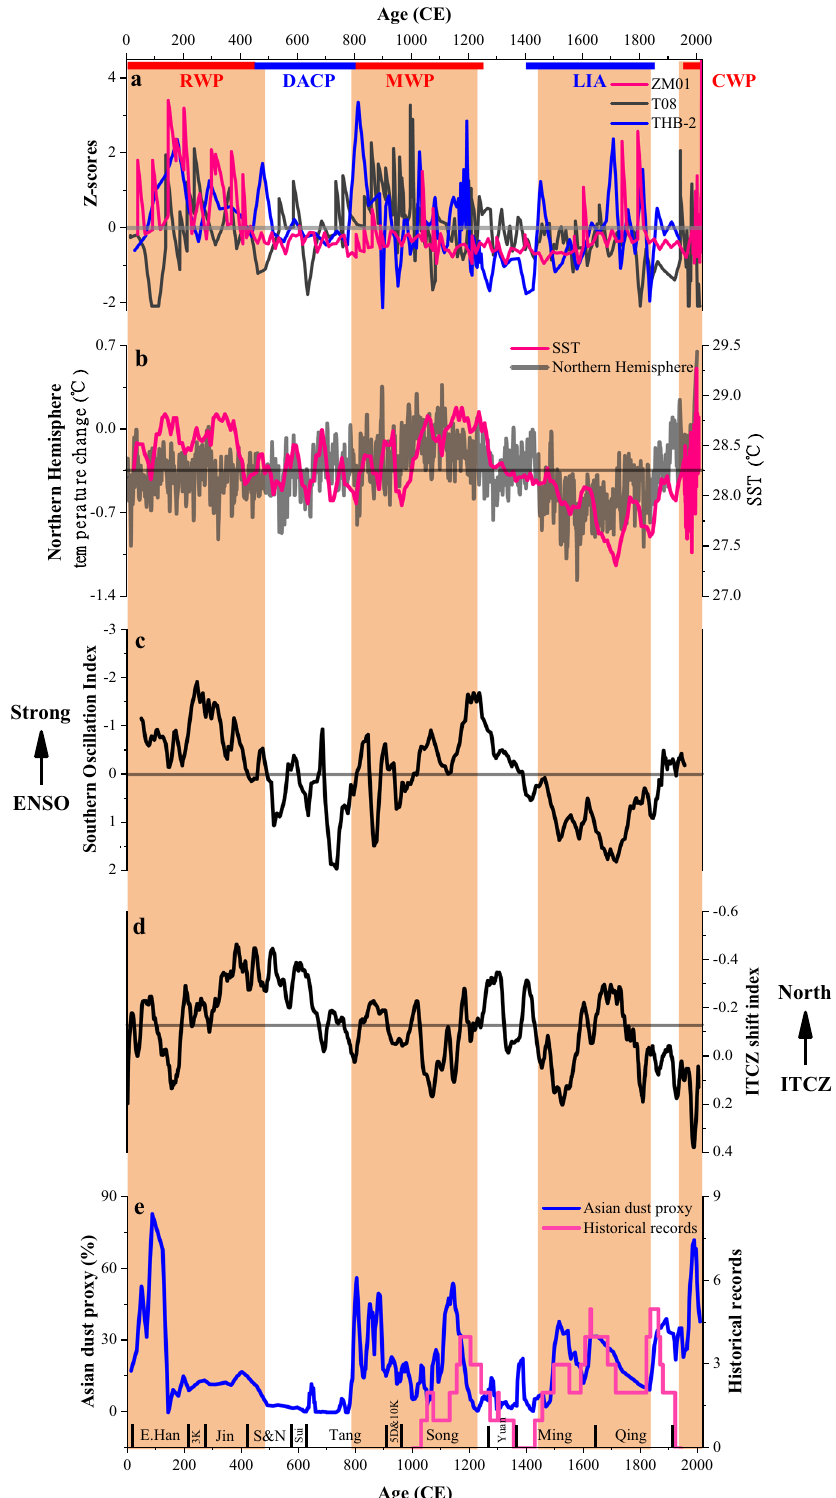
Fig. 6 Comparison of TC activity reconstructions with other paleoclimatic proxies in the northwestern Paci fi c. a Normalized sand content from cores ZM01, T08 25 , and THB-2 38 . b Temperature reconstructions from the Indo-Paci fi c warm pool 59 (tropical SST) and Northern Hemisphere 60 . c ENSO reconstructions from the equatorial Paci fi c 35 . d Reconstruction of the ITCZ from Klang Cave in southern Thailand, central Indo-Paci fi c 63 . e Later Holocene change in Asian dust activity from Lake Gonghai, northern China 66 , and historical records 67 . Gray lines represent the average value of the parameters, and the orange- fi lled columns represent periods of increased TC activity. Chinese dynasties since the East Han (E. Han) are indicated at the bottom. 3 K three Kingdoms; S&N Southern and Northern Dynasties, 5D&10 K fi ve Dynasties and ten